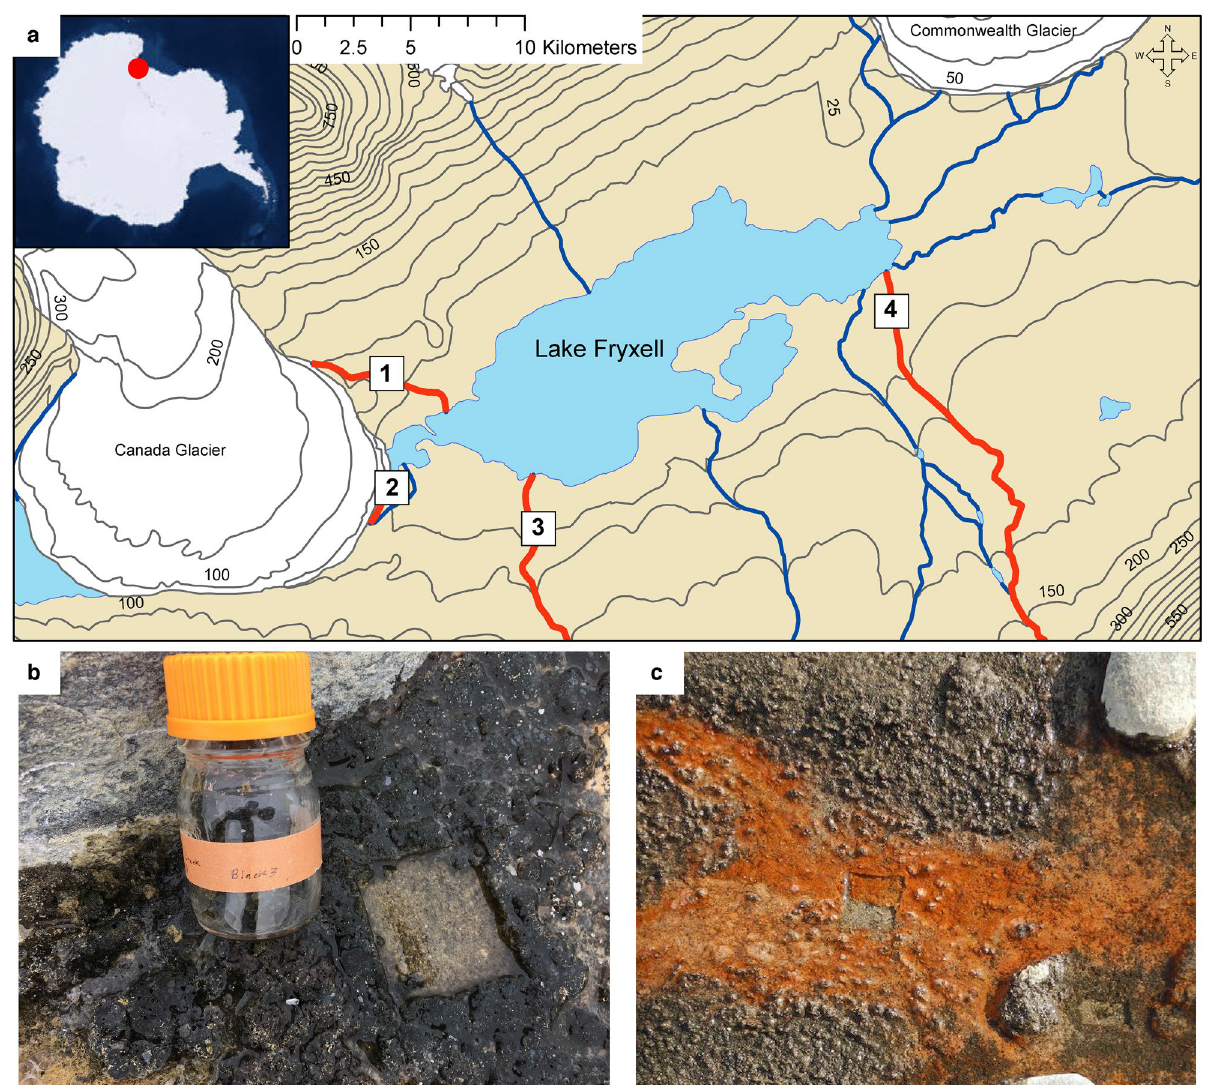
Figure 1. Locations and types of mat samples used for this study. ( a ) Map of the Lake Fryxell Basin in Taylor Valley, Antarctica with exact sampling sites (white squares) along streams (red lines: 1. Canada Stream, 2. Bowles Creek, 3. Delta Stream, 4. Von Guerard Stream). Blue lines indicate other streams not included in this study. Types of mats included in this study: ( b ) black type and ( c ) orange type with orange type showing regrowth 12 months post sampling. Photo credit: Josh Darling and Mike Gooseff. Map was created with ArcGIS Desktop 10.8.2 (http:// www. esri.